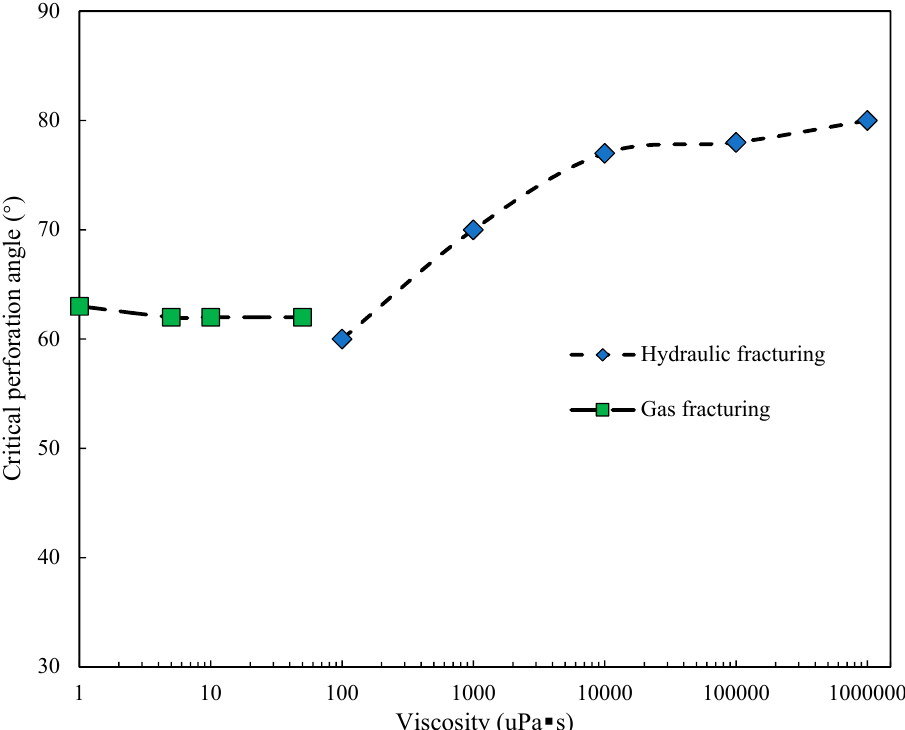
Figure 15. The relationship between critical perforation angle and stress ratio.